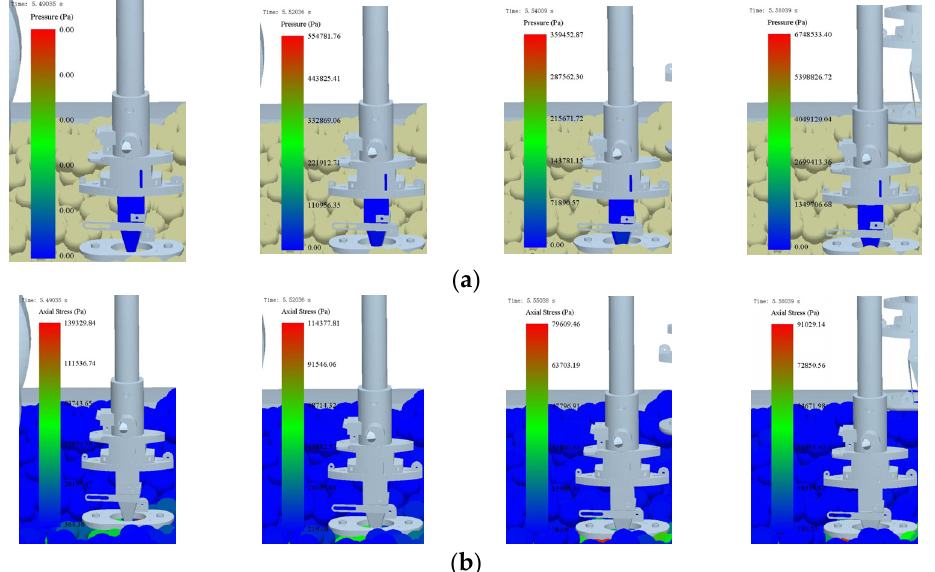
Figure 14. Entry soil stress change in the cavity seeder in sandy loam. ( a ) Duckbill stress. ( b ) Soil stress.